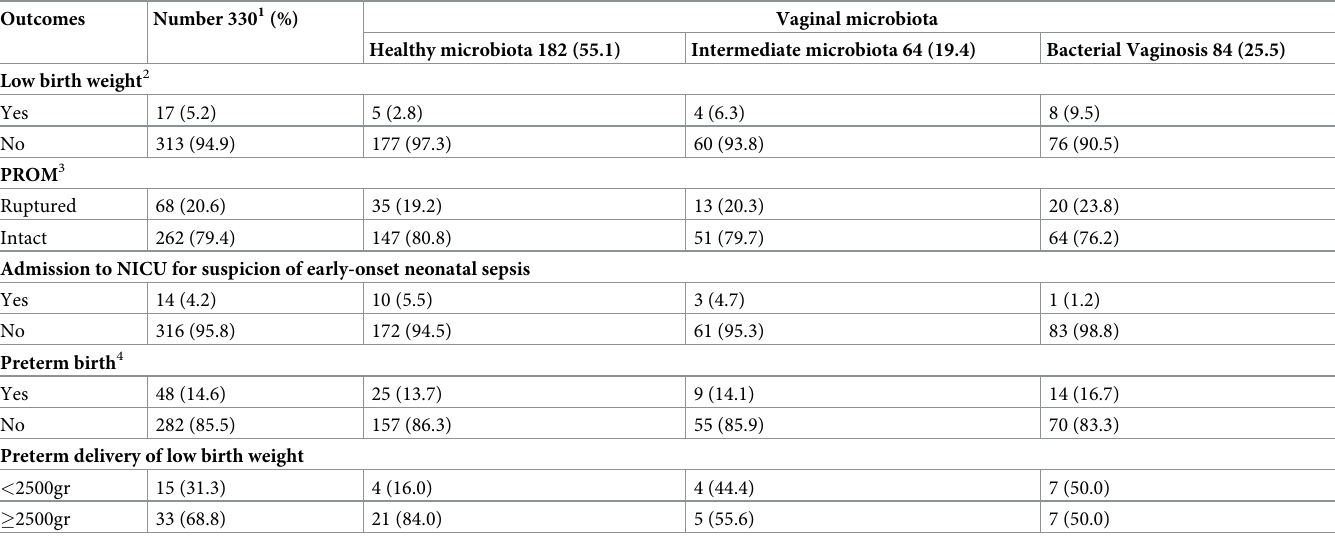
Table 2. Pregnancy outcomes stratified by vaginal microbiota